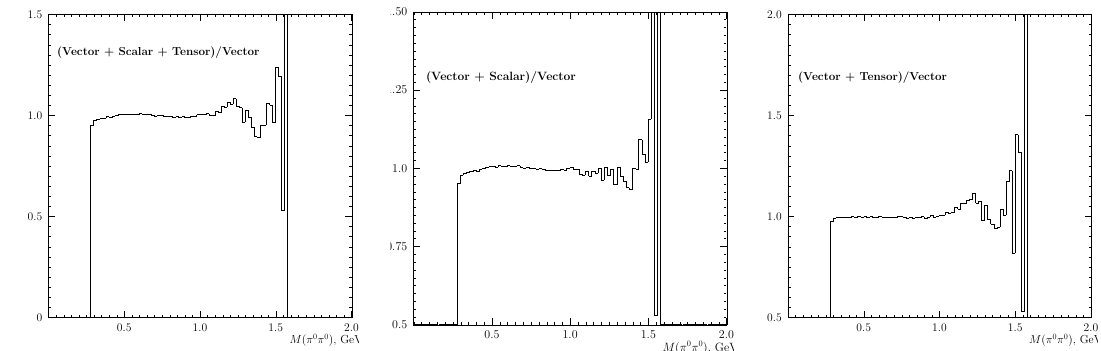
Figure 5 . a) Ratio of the vector+tensor+scalar and only vector √ s 3 = M π 0 π 0 spectral function for τ ν τ π 0 π 0 π − ; b) Ratio of vector+scalar and only vector; c) Ratio of vector+tensor and only → vector. All the plots use the inputs in table 1 ( c d = 26 MeV).